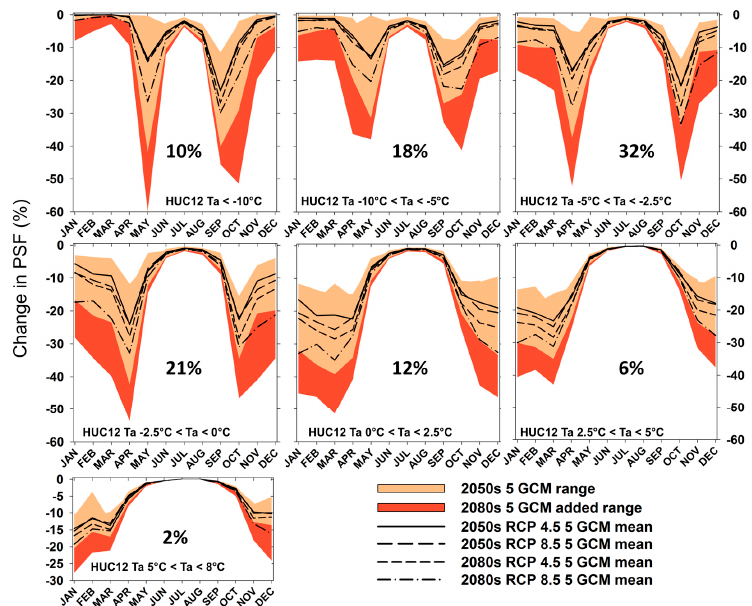
Figure 3. 2050s and 2080s means and ranges of projected monthly projected snow day fraction (PSF) change scenarios. Each panel represents mean projected changes extracted from Alaska 12-digit Hydrologic Unit Code (HUC12) watersheds in the 1970–1999 mean annual temperature (Ta) within the indicated range. Ranges include projections from Representative Concentration Pathway (RCP) 4.5 and RCP8.5. Percent values indicate the percentage of Alaska’s area in each of the temperature categories.